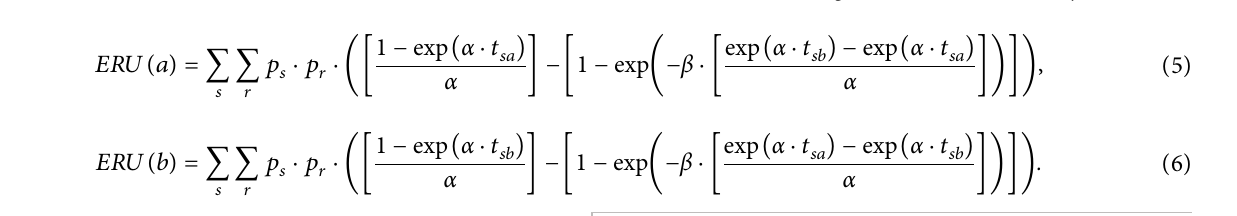
Figure 3: Influence of regret aversion on the utility difference.